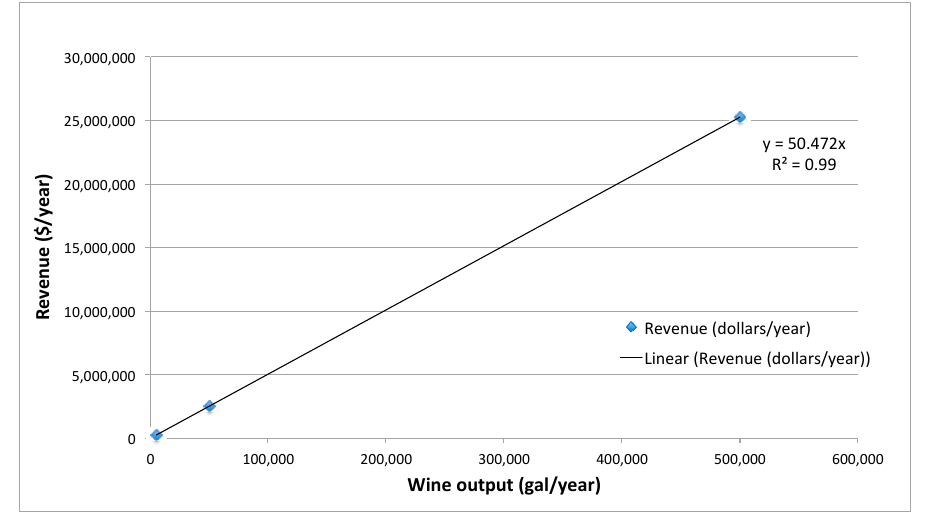
Figure 9. Annual revenues according to scale of operation (showing linear trendline).